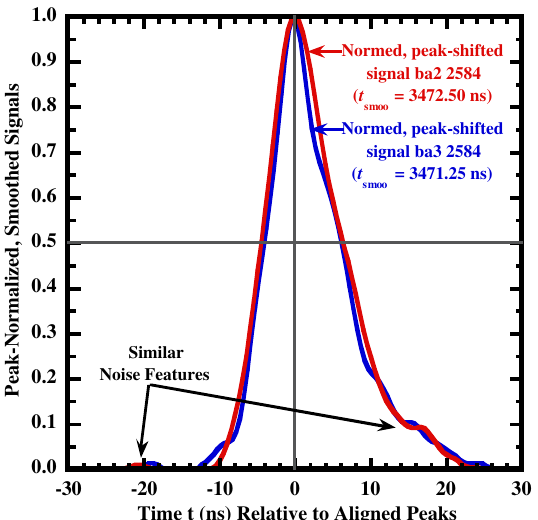
FIG. 5. Overlay comparison of (smoothed) signals from the dual, two-channel detector (BA2 and BA3). In this case, the recorded signals were closely similar in shape and separated by 1.3